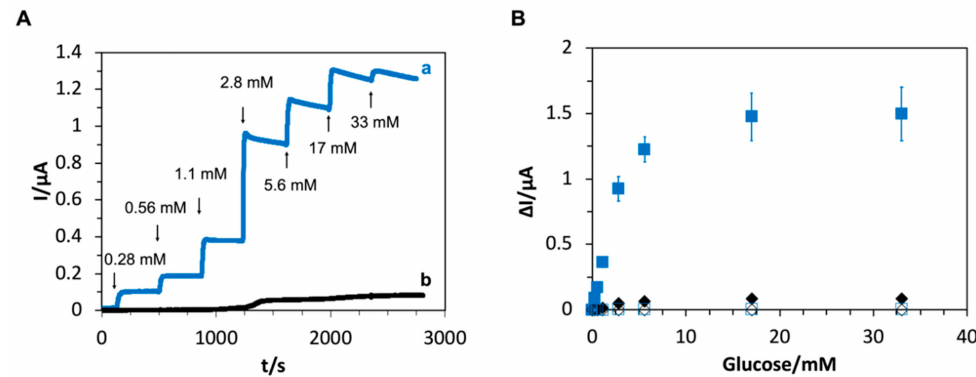
Figure 3. ( A ) Time courses of chronoamperometric measurements with (a) PES-modified An GOx-I489K and(b)PES-modified An GOx-WT.Applicationpotential0mVvs. Ag / AgCl.Arrowsindicatetheaddition of glucose. Concentrations over arrows are of the total glucose after addition. ( B ) Dependence of responsecurrentonglucoseconcentrationforPES-modified An GOx-I489K(filledsquares), PES-modified An GOx-WT (filled diamonds), unmodified An GOx-I489K (open squares), and unmodified An GOx-WT (open diamonds). Application potential 0 mV vs. Ag /